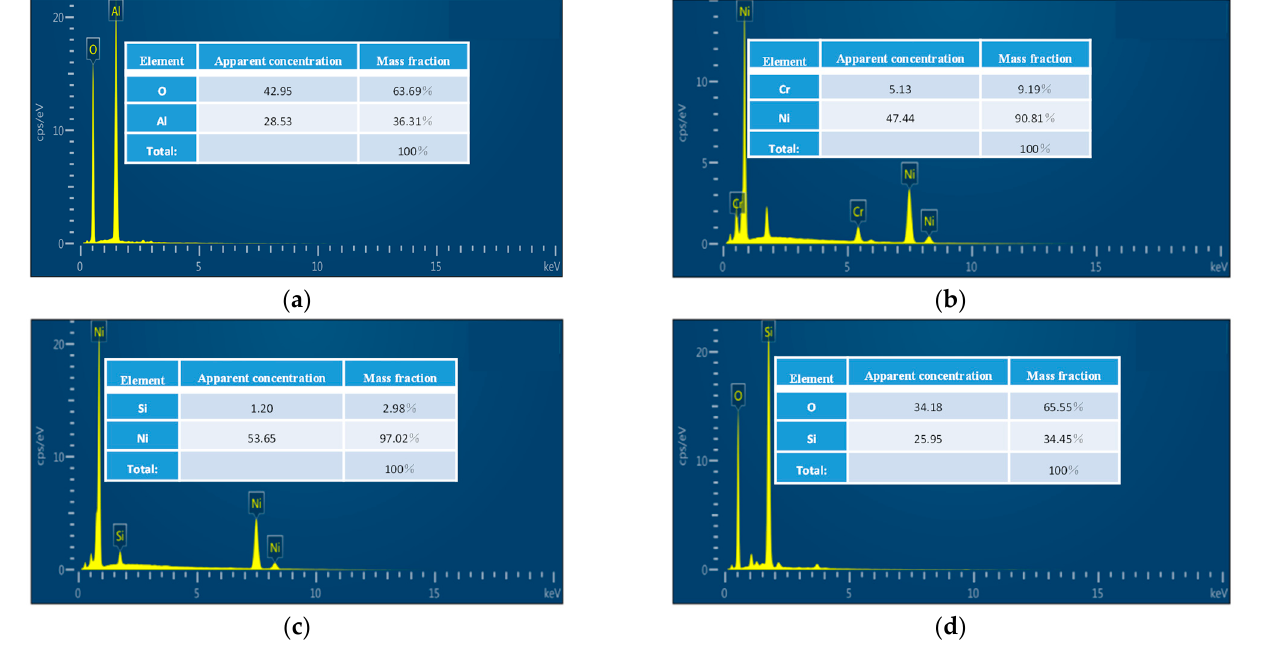
Figure 7. SEM image of functional film surface: ( a ) Al 2 O 3 thin films surface; ( b ) NiCr thin films sur- face; ( c ) NiSi thin films surface; ( d ) SiO 2 thin films surface.